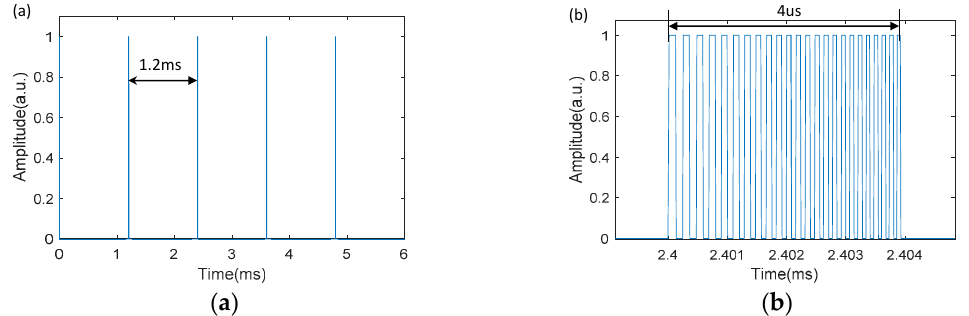
Figure 5. Schematic block diagram of the digital linear frequency modulation (LFM)-based optical time domain reflectometry. FP-LD: Fabry–Perot (FP) laser diode; FPGA: field-programmable gate array; APD: avalanche photodiode; FUT: fiber under test; ADC: analog-to-digital converter; DSP: digital signal processor.